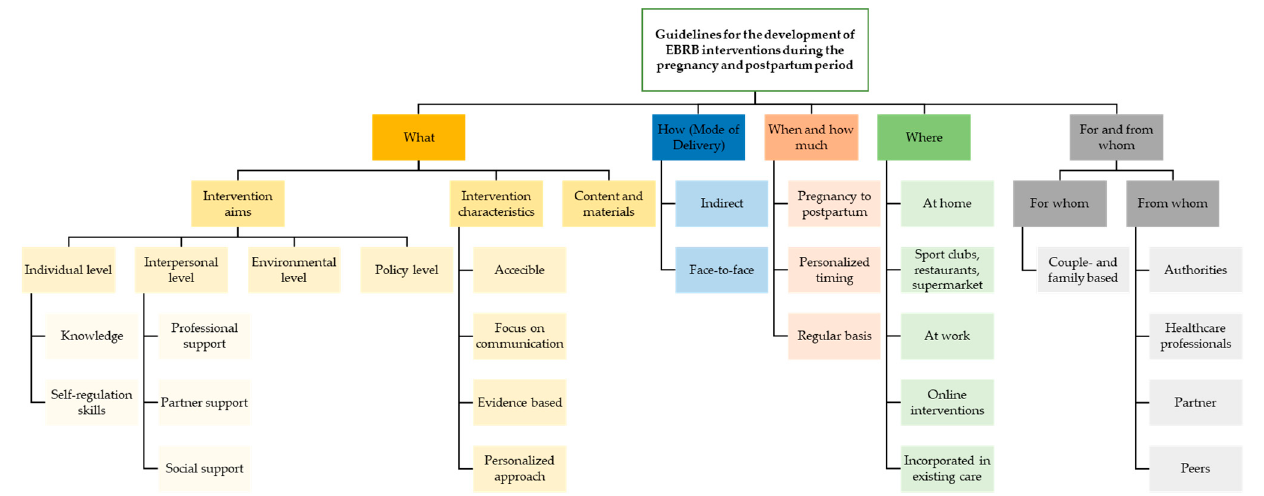
Figure 2. Overview of categories to consider when developing intervention strategies aiming to obtain/maintain healthy energy balance-related behavior (EBRB) during the pregnancy and postpartum